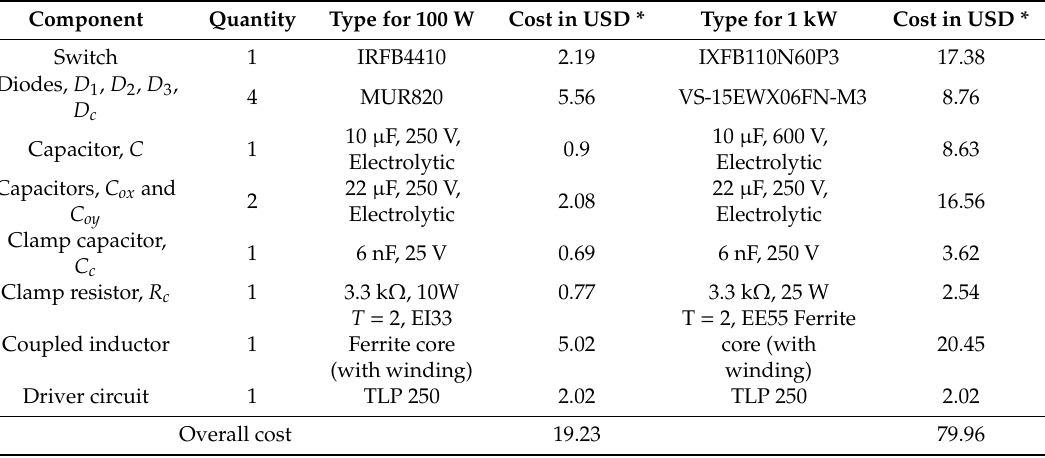
Table 6. Cost details of the proposed converter.